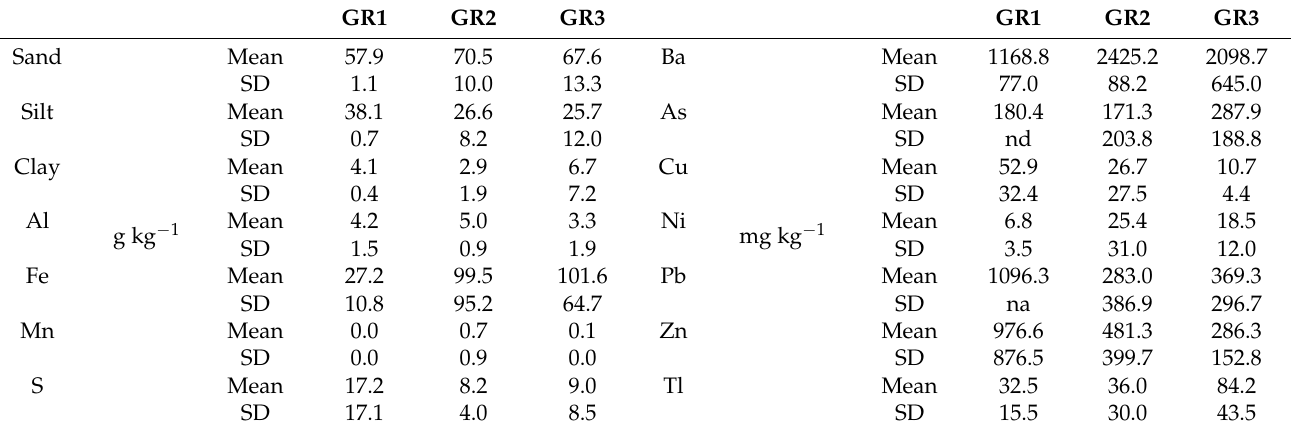
Table 2. Physicochemical characteristics’ mean and standard deviation (SD) of soil samples collected from the C horizons of soil profiles in mining rocks deposits (GR1), soils formed on coarse debris of mining landfill or on altering mine debris (GR2), soils formed on mining flotation deposits